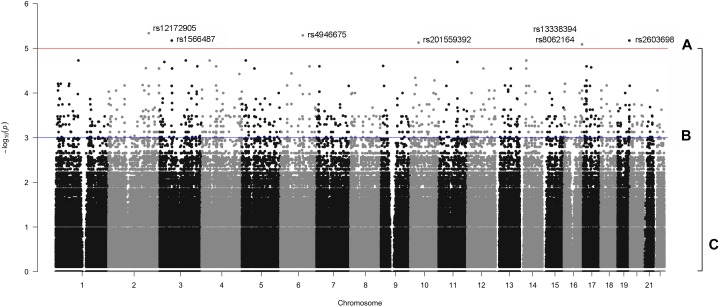
Manhattan plot displaying single variant association signals (–log10
P-value) plotted against chromosomal location. (A)
p < 1 × 10−5, (B)
p < 1 × 10−3, and (C), all variants.